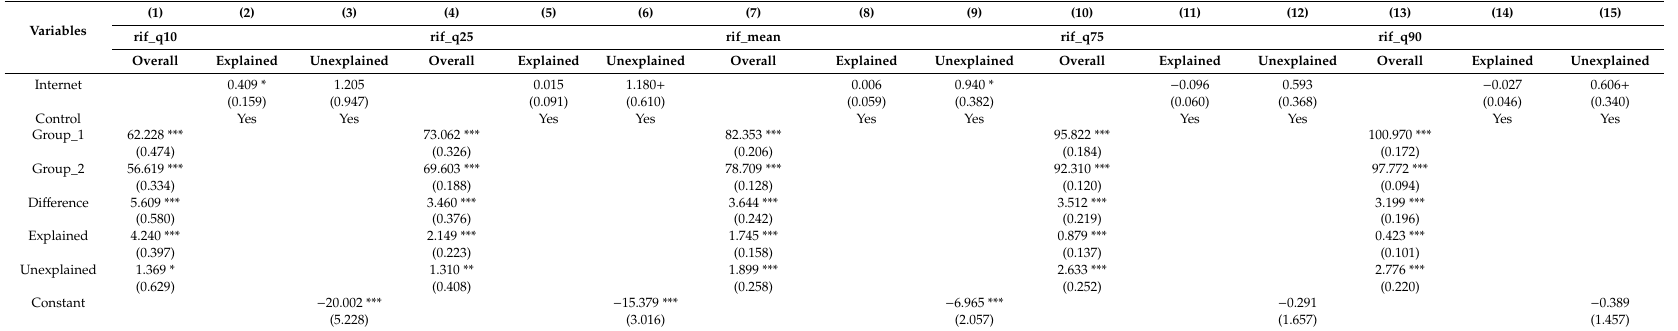
Table 3. RIF decomposition of di ff erences in psychological well-being between non-agricultural and agricultural hukou holders.